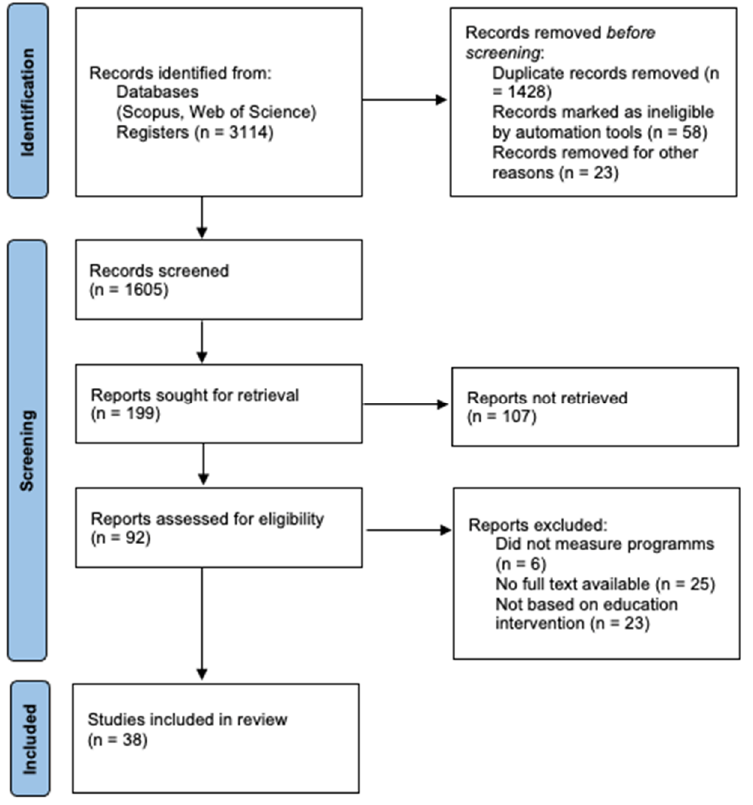
Figure 1. Flow diagram of the screening process for systematic reviews and meta-analyses (PRISMA).